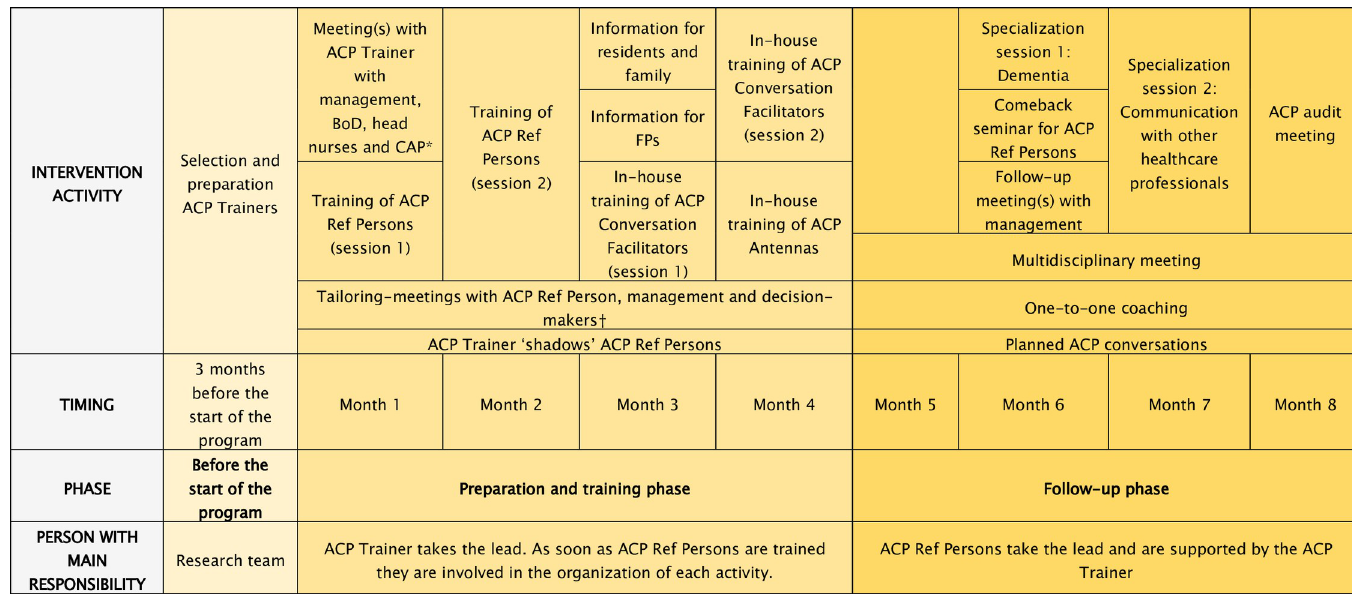
Fig 1. Timeline of the final ACP+ program. ACP advance care planning; BoD board of directors; CAP coordinating advisory physician; ACP Ref Person advance care planning reference person; FP family physician. The figure outlines the timeframe of the ACP+ program as how it will be evaluated in the subsequent trial. � Nursing homes are legally obliged to have at least one coordinating and advisory physician (CAP) (remunerated according to the number of beds), who coordinates medical care in the facility, as well as reference nurses for palliative care (0.10 FTE per 30 residents) [46]. †Important decision-makers include head of nursing staff, head of residents’ care, management; all those involved with decision-making tasks in the nursing